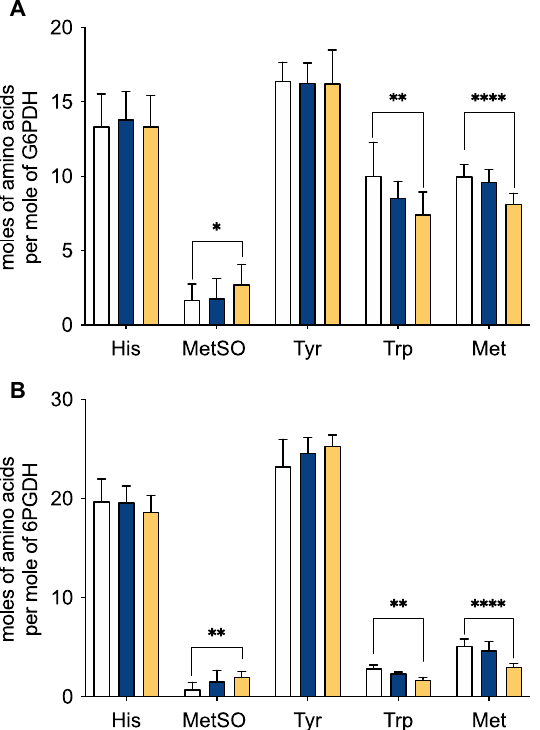
Figure 4. Quantification of His, Tyr, Trp, and Met modification and formation of methionine sulfoxide (MetSO) in samples of G6PDH (panel A ) and 6PGDH (panel B ) treated with 10 (blue) and 100 (orange) mM AAPH. G6PDH (54 μM monomer) and 6PGDH (58 μM monomer) were incubated with AAPH at 37 °C in 75 mM phosphate buffer at pH 7.4 for 180 min. Aliquots were then taken, AAPH removed, and amino acid content assessed by OPA derivatization and HPLC analysis, as described in the Material and methods. Results were normalized to the concentration of Leu residues (to compensate for any losses during processing), and are expressed as moles of residue per mole of protein. The white bars show data determined at time zero. Incubations for 180 min of proteins in the absence of AAPH showed minor changes in amino acid content (data not shown). Data correspond to means ± standard deviations of at least three independent hydrolyses, from three independent experiments. Statistical differences are indicated as follows: *p < 0.05, **p < 0.01, and ****p < 0.0001.